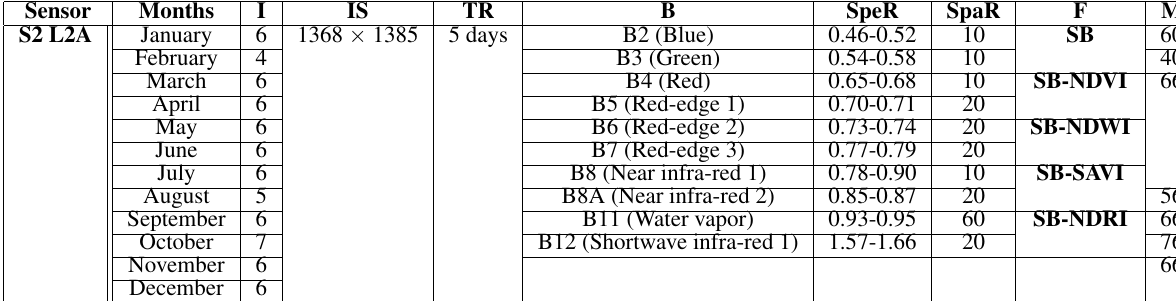
Table 1. Iota2 ( ι 2 ) configuration for monthly and yearly classifications over the study area. Sensor